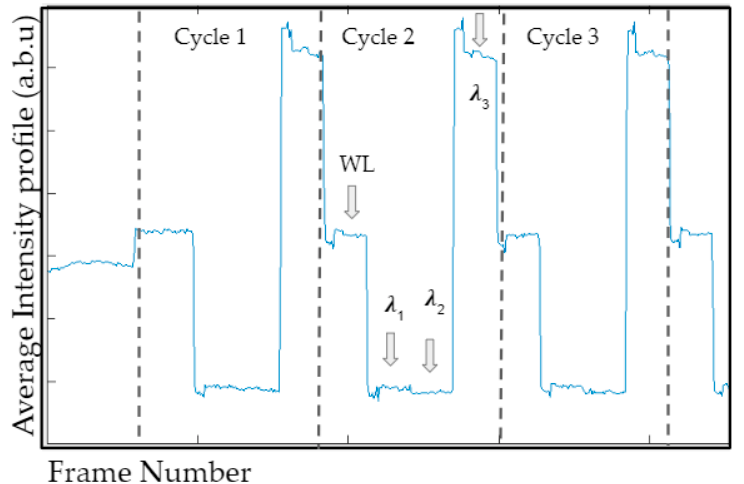
Figure 3. Sample average intensity profile collected across all three NIR wavelengths (690, 800, and 840 nm) and white light (WL), obtained via multiplexing LED light sources and reference white light.